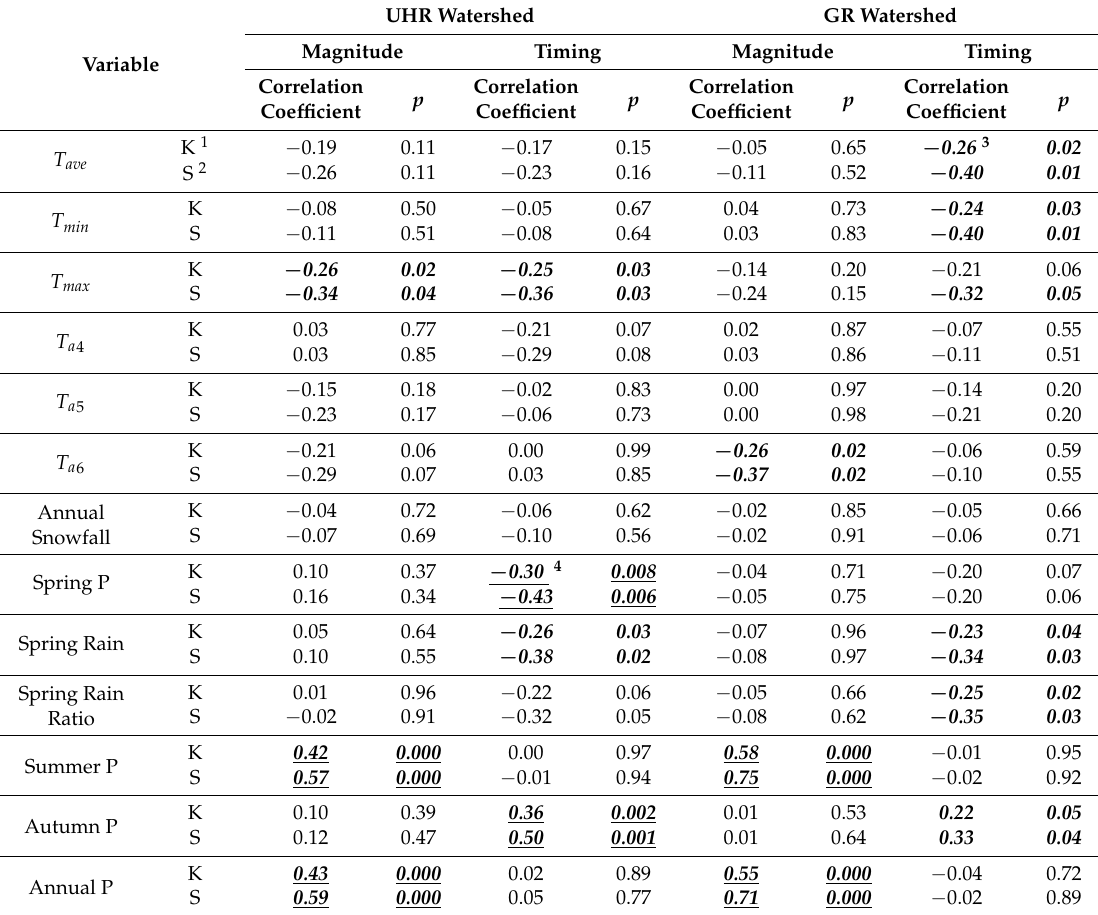
Table 3. Correlation analysis between high flow regime components and climatic variables in the UHR and GR watersheds. UHR